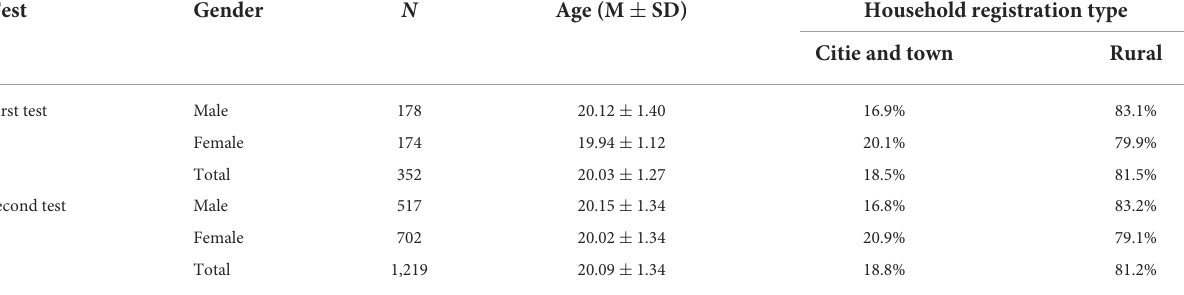
TABLE 2 Personal information of survey